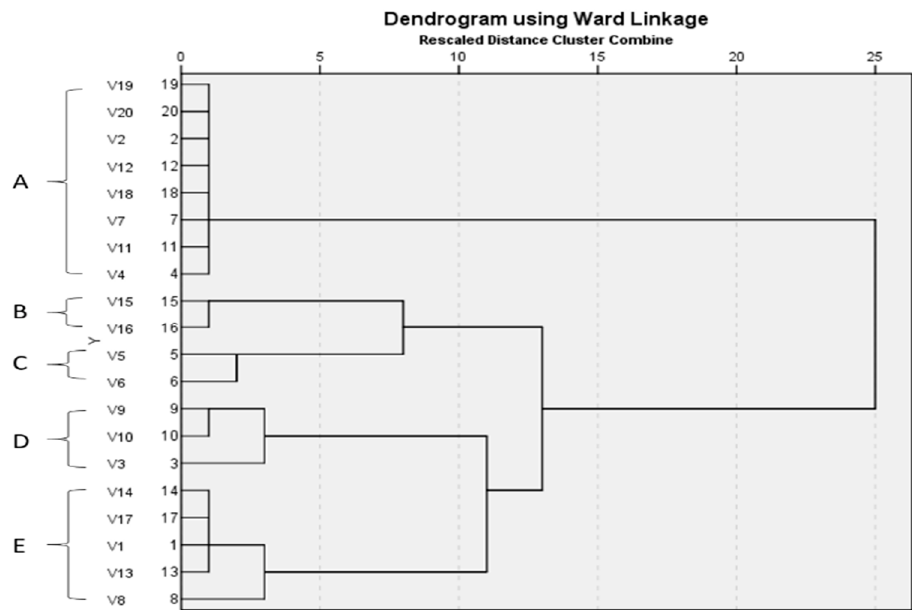
Figure 2. Dendrogram showing the degree of relatedness of S. enterica isolates as determined by ERIC-PCR